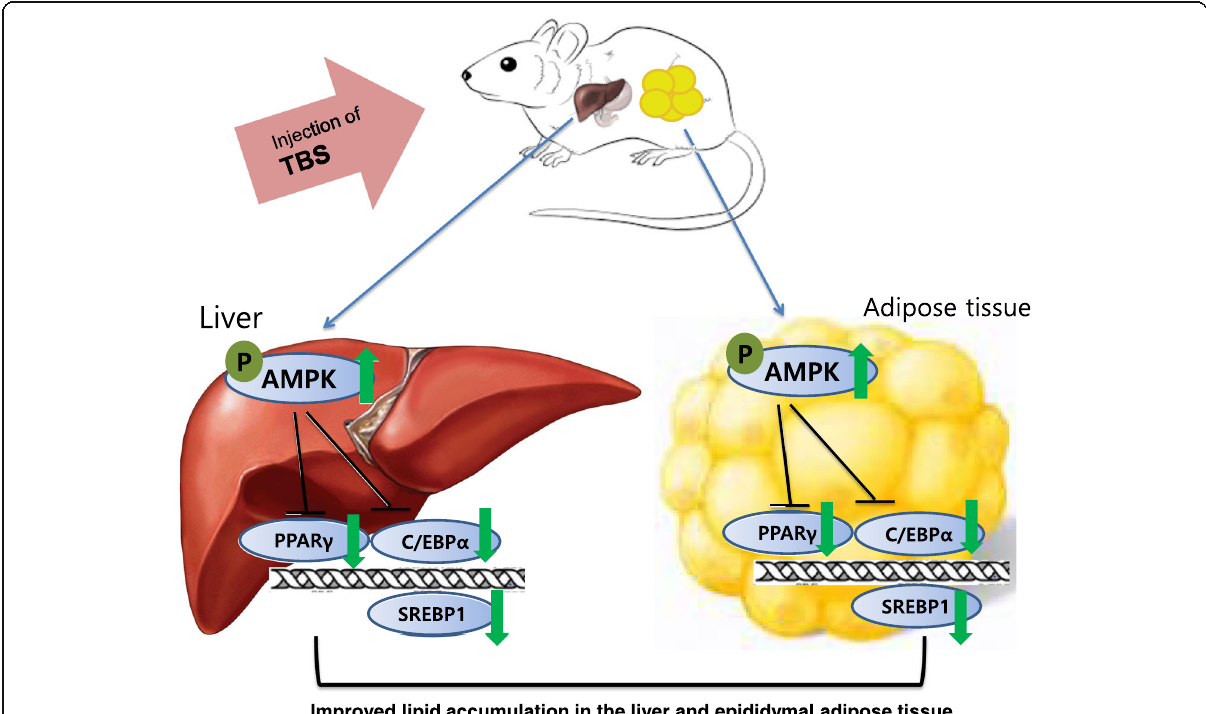
Fig. 7 The mechanism of TBS. TBS injections significantly reduced lipid accumulation by regulating the expression of AMPK, PPAR γ , C/EBP α , and SREBP1 in the liver and epididymal white adipose tissue of an HFD-induced obese mouse